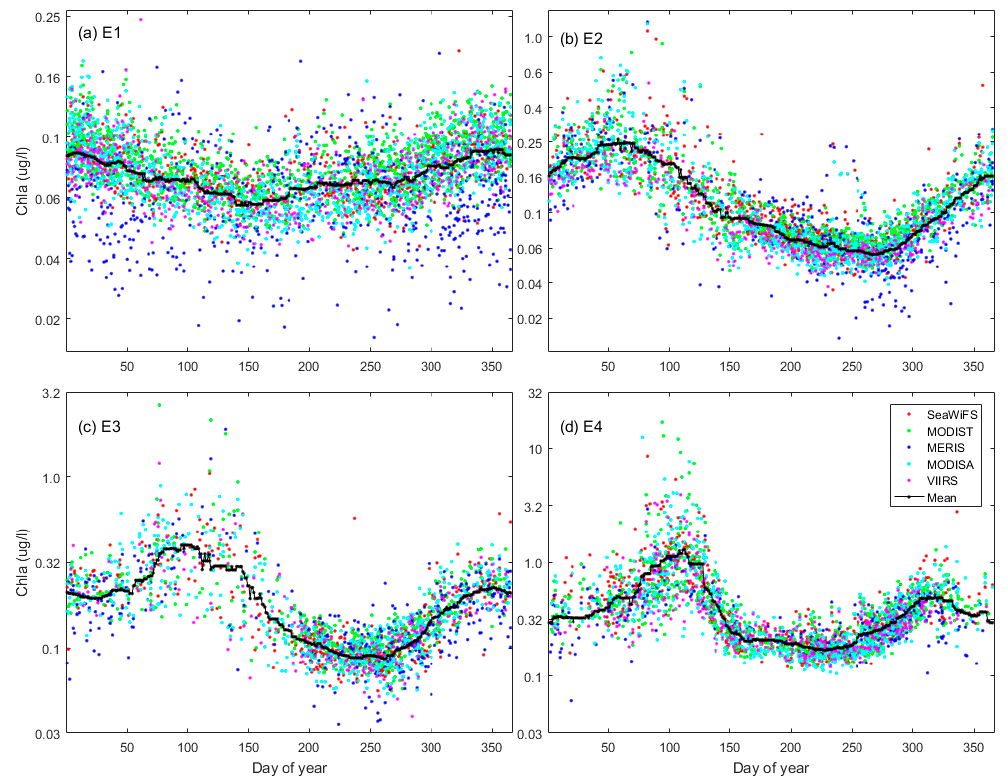
Figure 10. Comparison of Chl-a from five satellites against the day of year with the climatology at site E1 ( a ), E2 ( b ), E3 ( c ), and E4 ( d